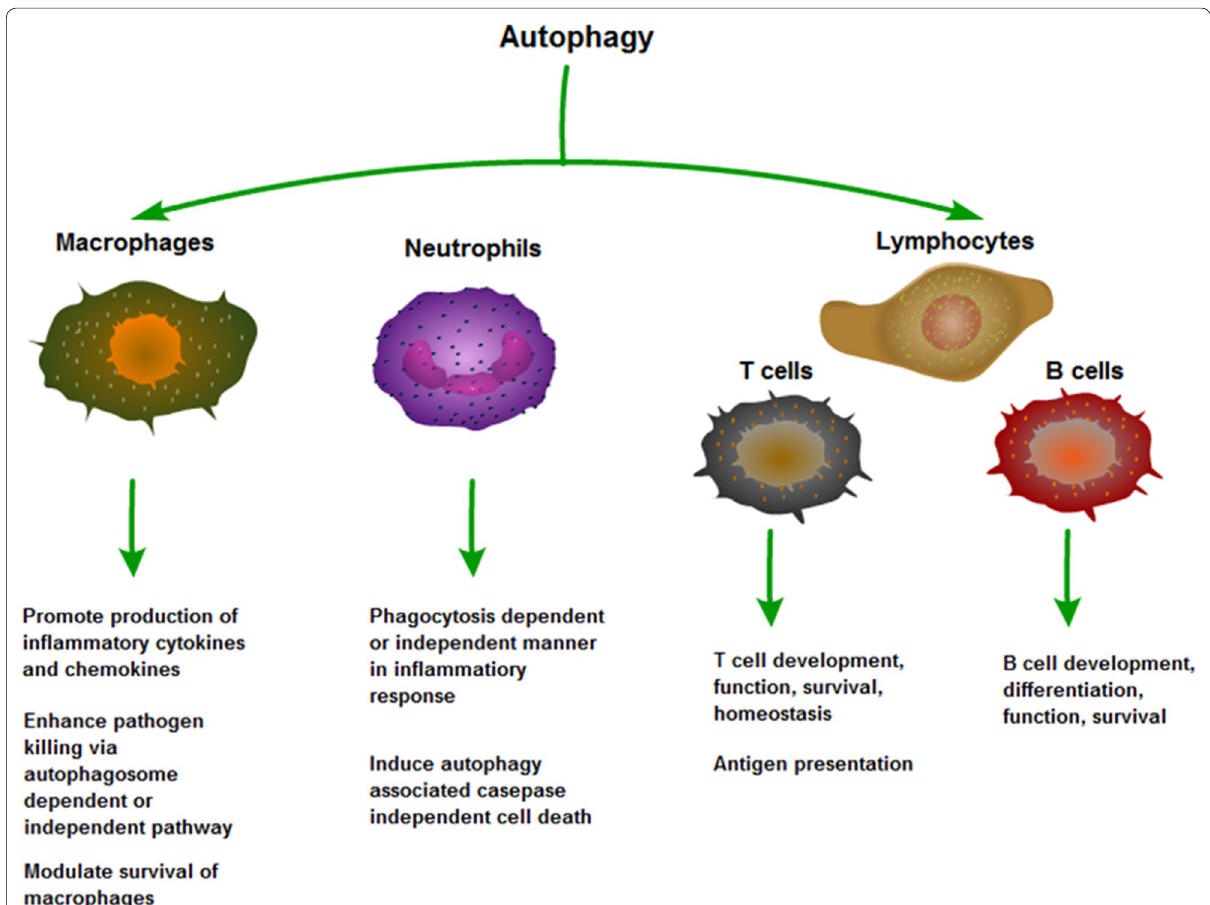
Fig. 2 Effects of autophagy in inflammatory cells. Autophagy influences the development, homeostasis and survival of inflammatory cells, includ- ing macrophages, neutrophils and T lymphocytes and B